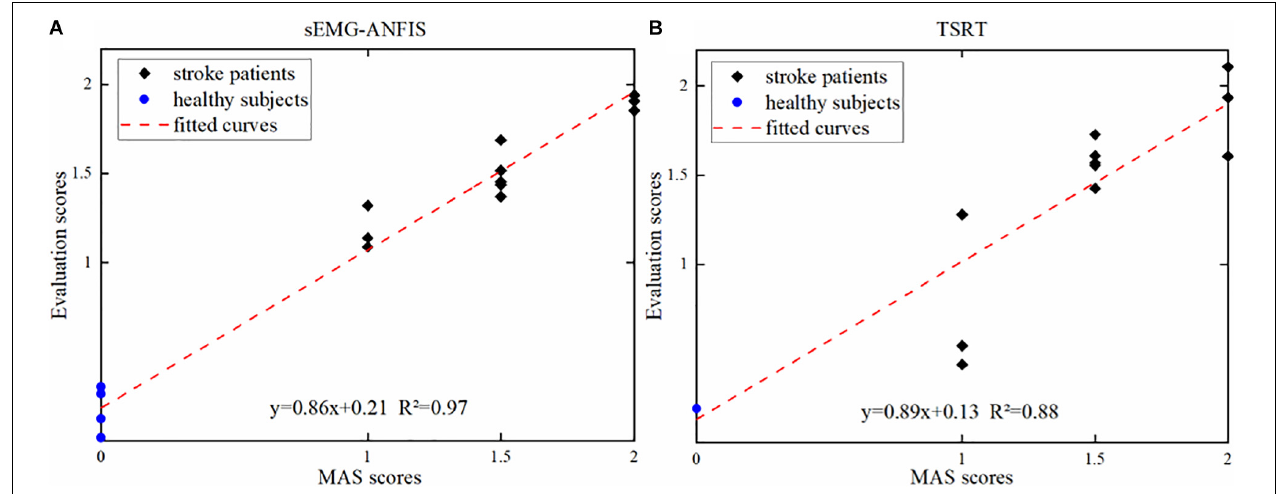
FIGURE 7 | (A) The evaluation scores from the sEMG-ANFIS method and the uniform MAS scores. (B) The evaluation scores from the TSRT method and the uniform MAS scores.